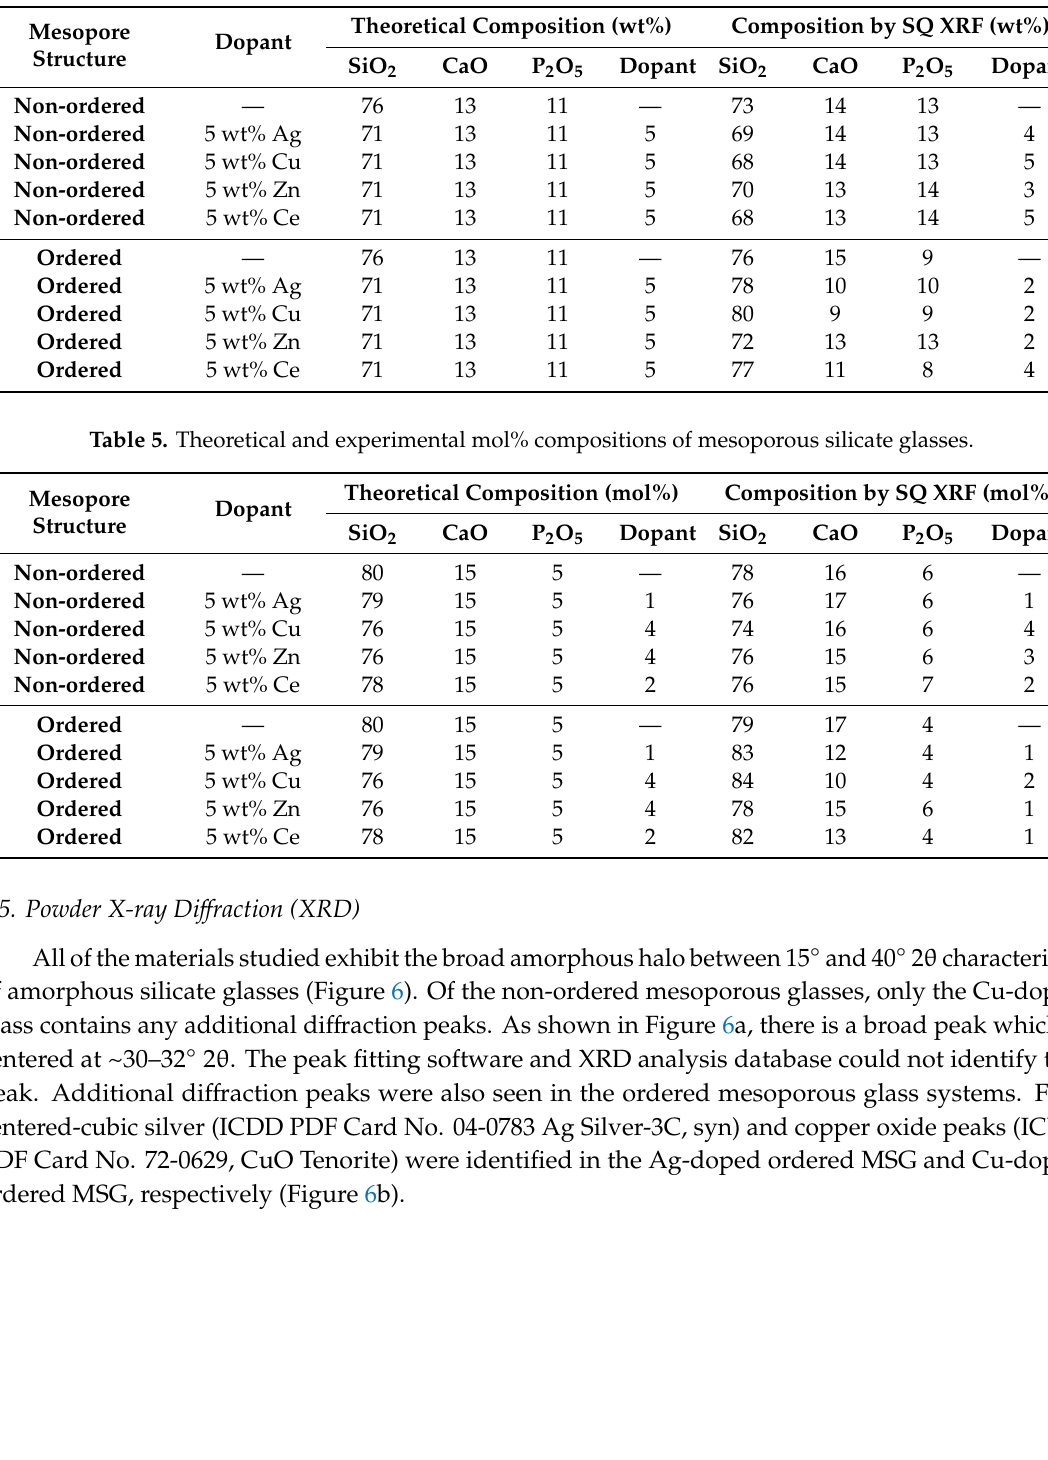
Table 4. Theoretical and experimental wt% compositions of mesoporous silicate glasses.